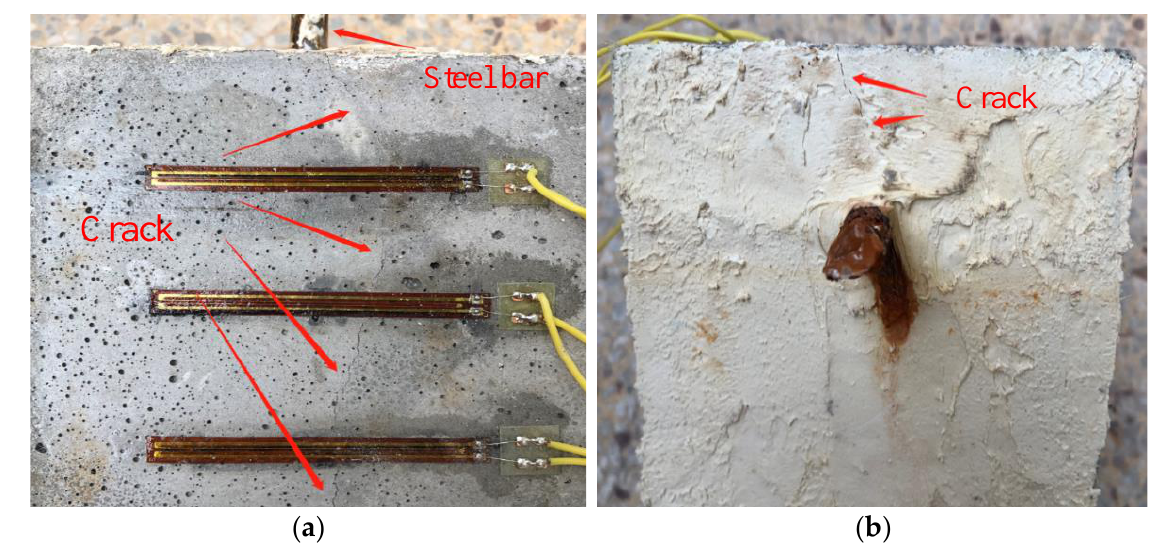
Figure 10. Cracking characteristics on the mortar cover during the corrosion experiment ( a ) crack on the gauges side, ( b ) crack on the exposed steel rebar side.